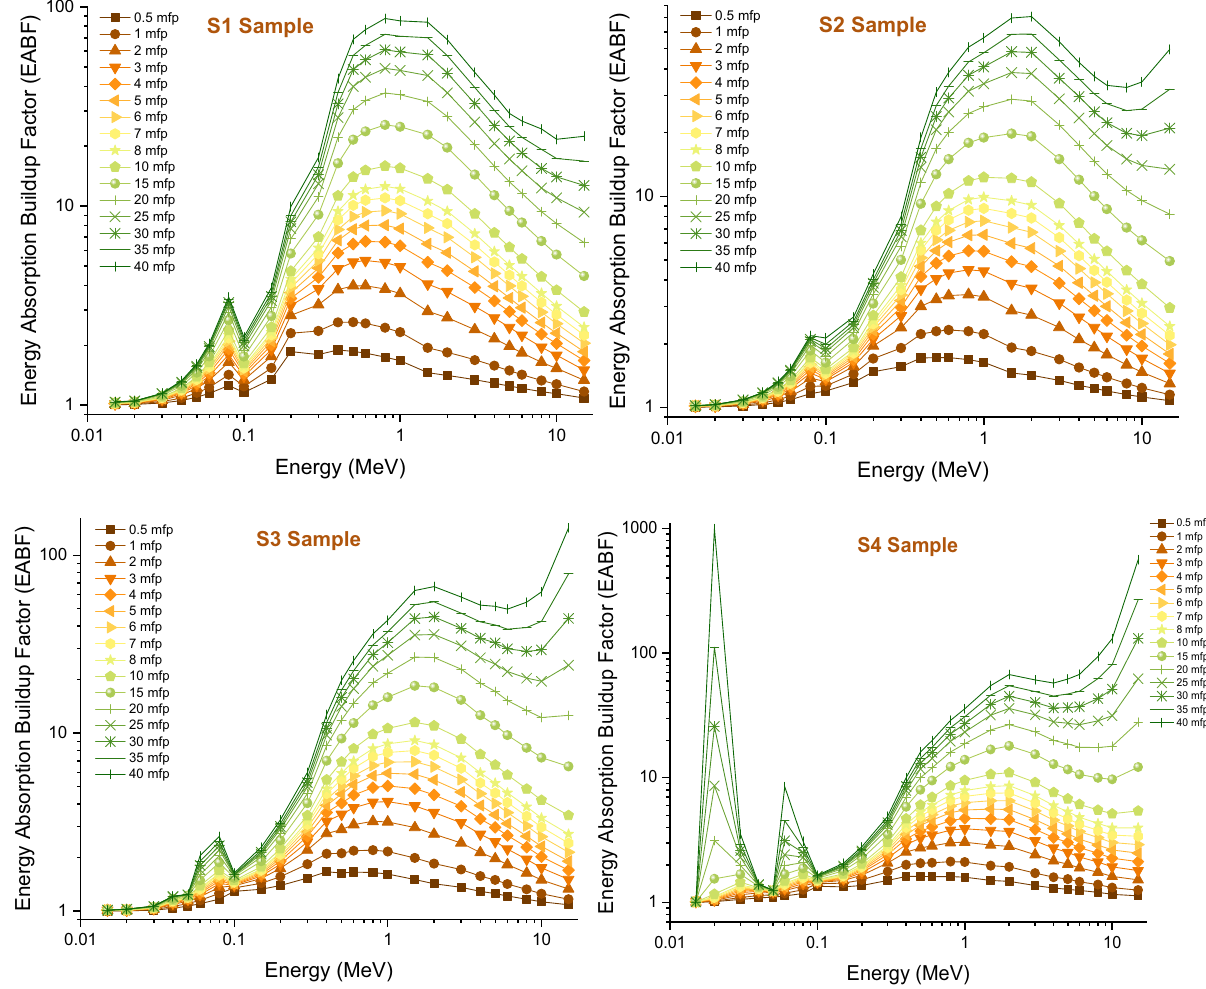
Figure 14: Variation of EABF of investigated glasses at di ff erent mean free path